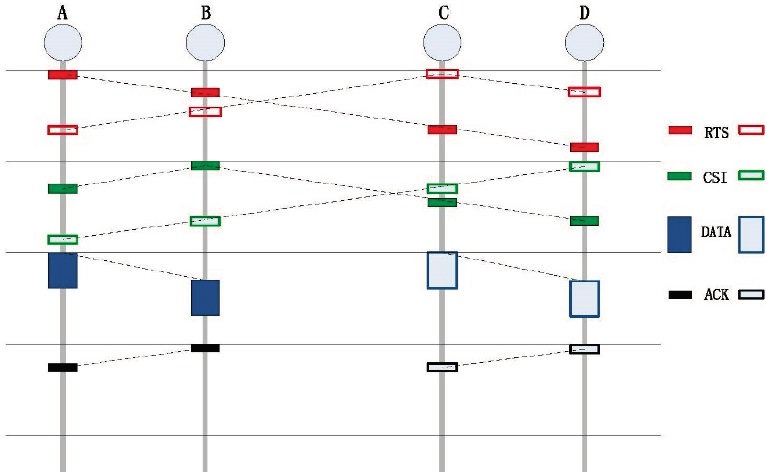
Figure 3. Environmentally Friendly Medium Access Control (EF-MAC)